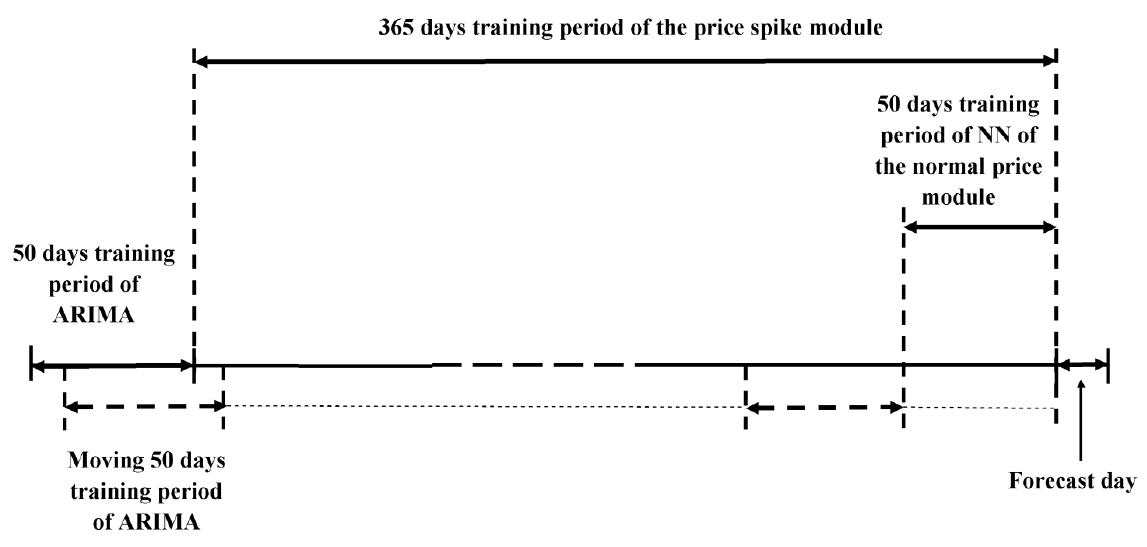
Figure 5. Historical data required for the training of the normal price and price spike modules to produce overall price forecast on a single forecast